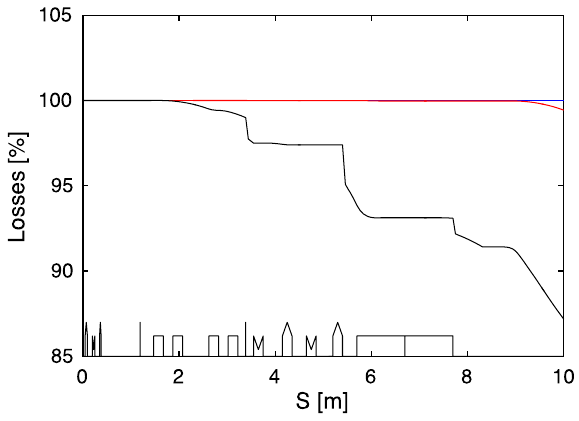
FIG. 12. Beam losses along COXINEL line assuming an energy spread of (blue) 1% rms, (red) 10% rms and (black) 20% rms together with a divergence of 1 mrad rms. Beam transport simulation in the nonlinear case with BETA and sympletic 6D tracking without collective effects using the S2I- CM optics with r 11 ¼ r 33 ¼ 10 and r 56 ¼ 0 . 4